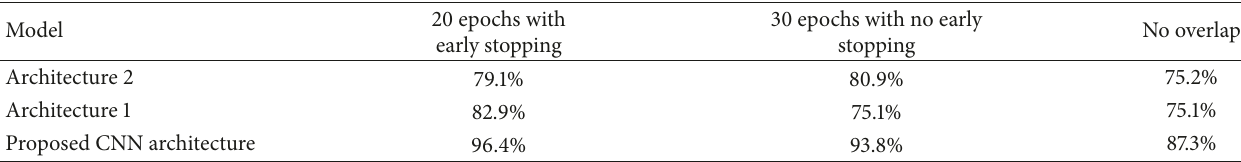
Table 29: Prediction accuracies for